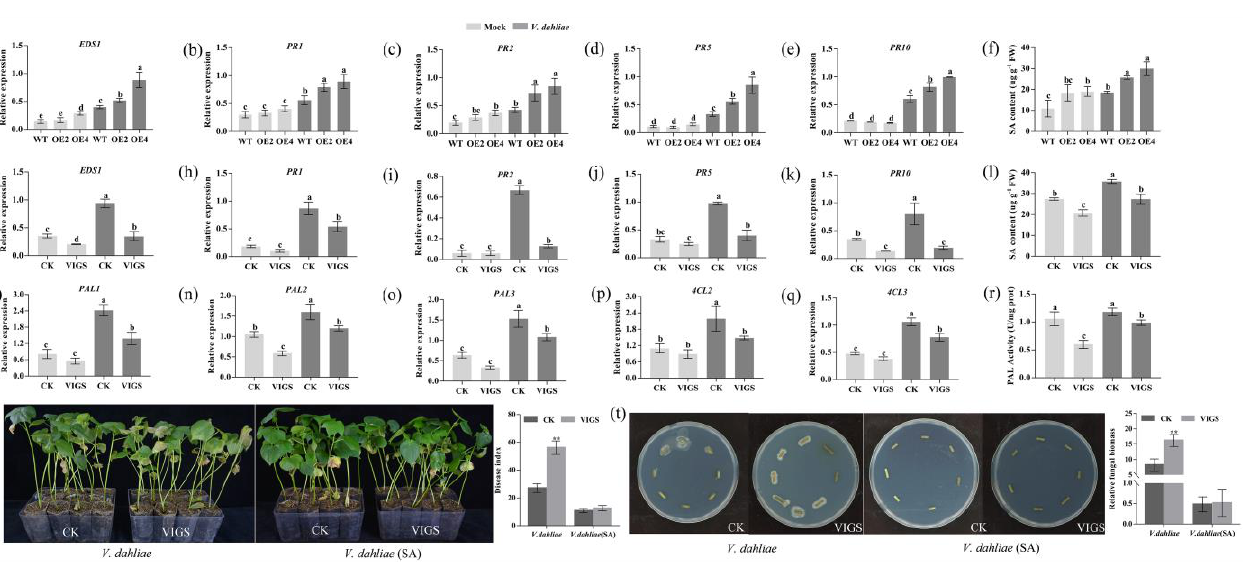
Figure 7. RNA-seq reveals that GhENODL6 overexpression affects immunity-related pathways of Arabidopsis . ( a ) GO enrichment analysis of the differentially expressed genes in plants of GhENODL6-4 transgenic line and the WT control. P adj. Corrected p -value after multiple hypothesis testing. GeneRatio: ratio of the number of differential genes annotated to the GO number to the total number of differential genes. ( b ) KEGG enrichment analysis of the difference in plants of GhENODL6-4 transgenic line and the WT control after challenged with V. dahliae for 24 h. KEGG terms were separately shown by enrichment analysis. p -value of 0.05 adjusted by multiple hypothesis testing.